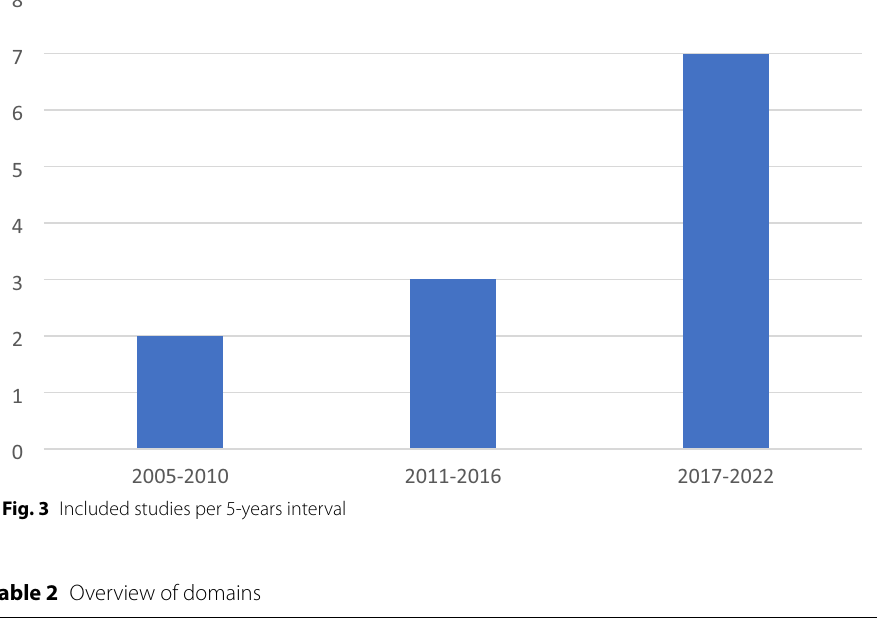
Table 2 Overview of domains Domain Studies Science 3